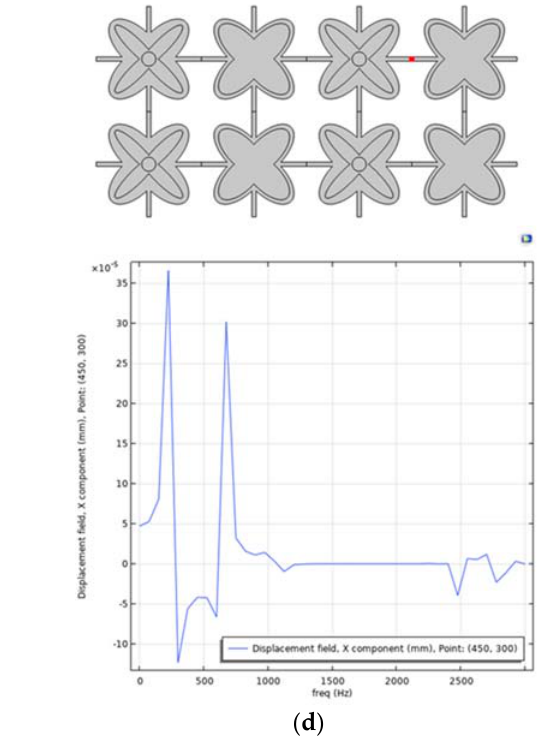
Figure 21. Deformation of microstructures for different eigenfrequencies.